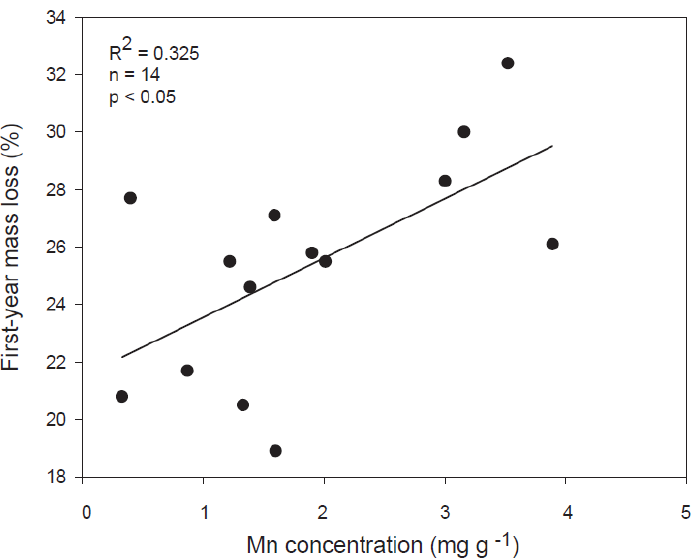
Figure 4. Bivariate plot of first-year mass loss vs. initial litter concentration of Mn. The study was made in a climatic gradient of 14 Norway spruce stands in Sweden, using local needle litter. The mean annual temperature in the gradient ranged from − 1.7 to 7.4oC. From